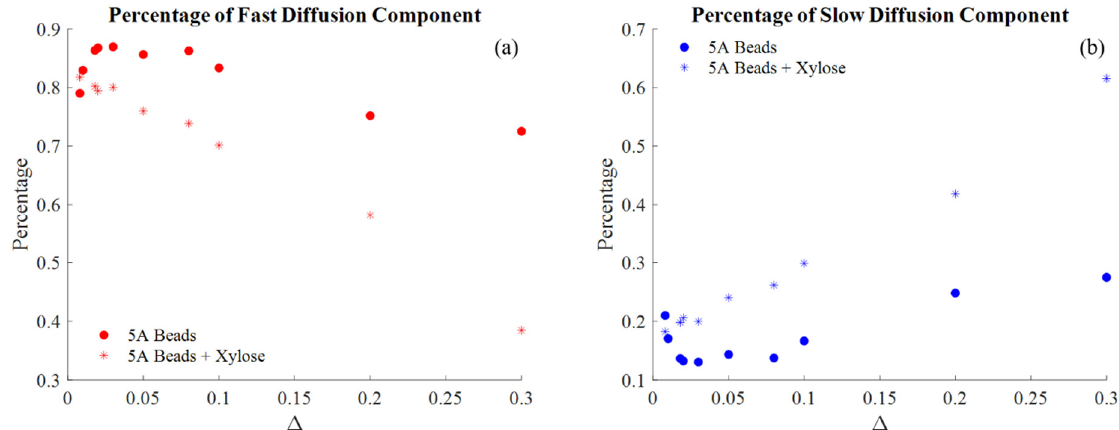
Figure 3. The population percentage of the fast ( a ) and slow ( b ) diffusion populations with varying Δ. The signal is weighted toward the slower diffusing regions before and after the addition of the xylose with increasing Δ.